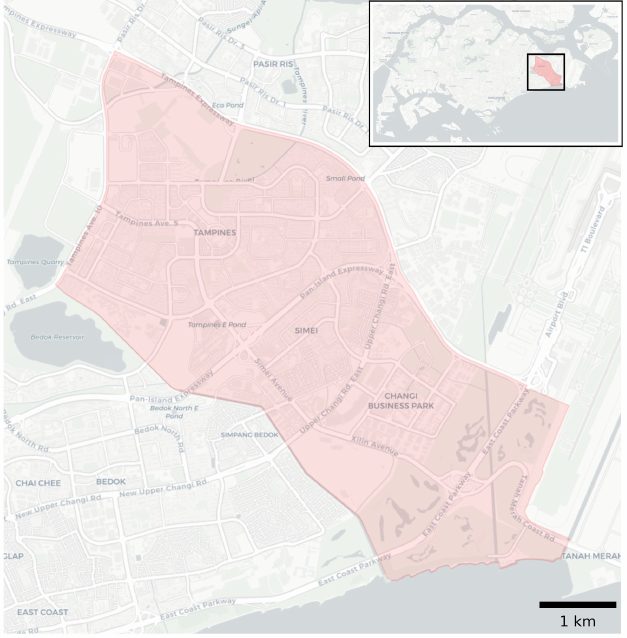
Figure 2. Overview of study area of Tampines (red polygon), located in east of Singapore (inset). Map tiles by Carto, under CC BY 3.0. Data by OpenStreetMap, under